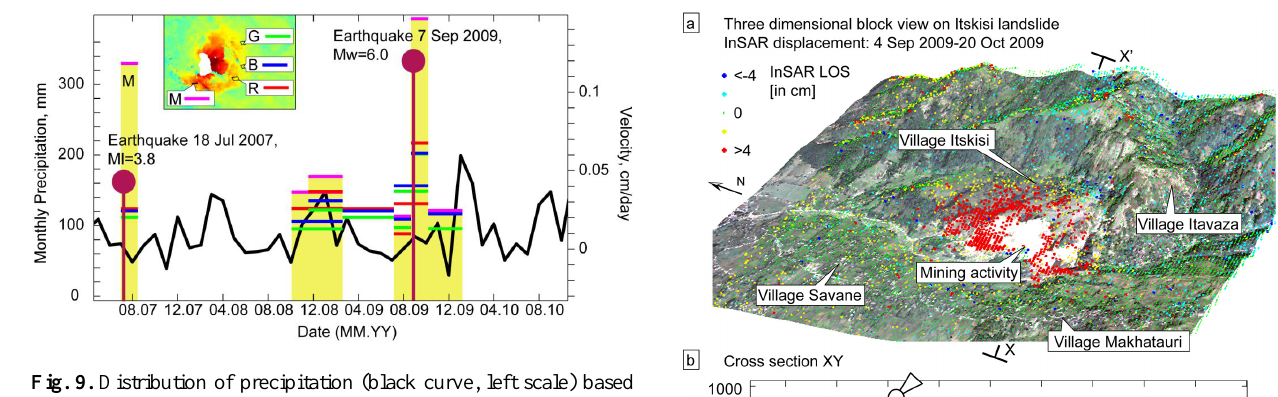
Table 1. Output parameters from inversion model for different interferograms (Fig. 8 (A-C)) 850